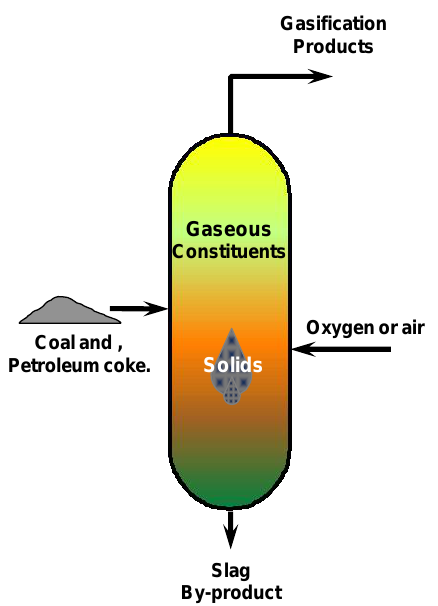
Figure 25. Typical Entrained Flow Gasifier [1].